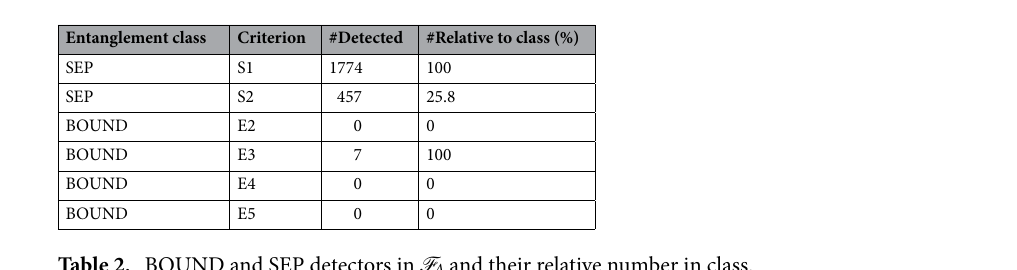
Table 2. BOUND and SEP detectors in F A and their relative number in class.